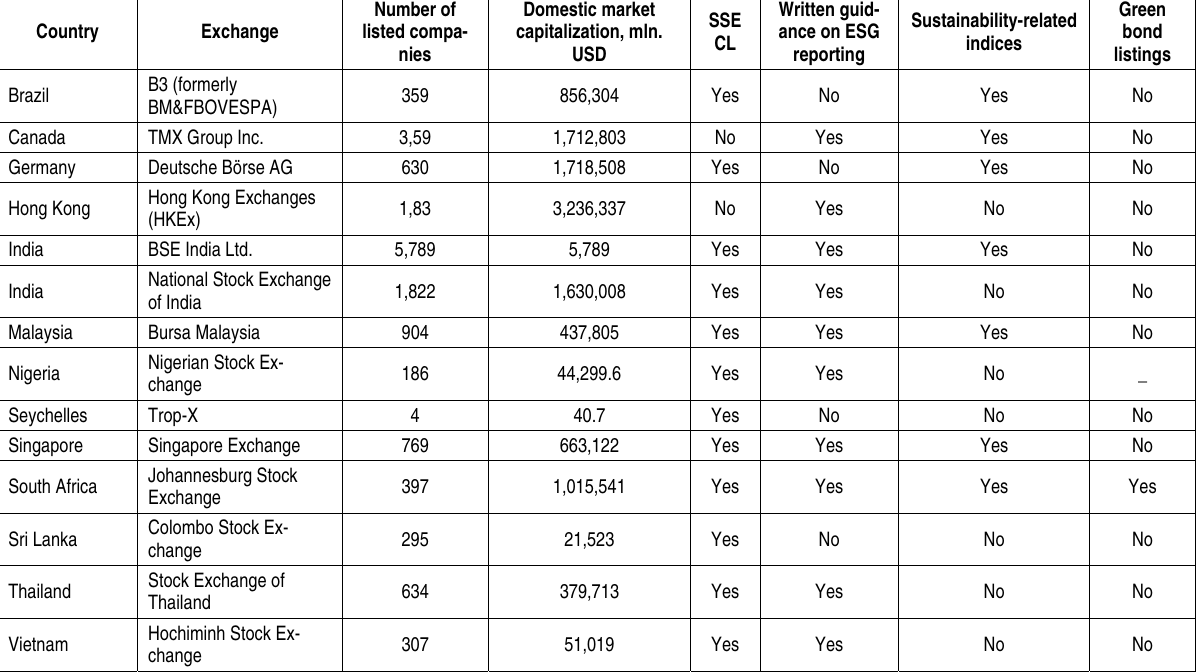
Table 5. Exchanges with ESG reporting as a listing rule as of